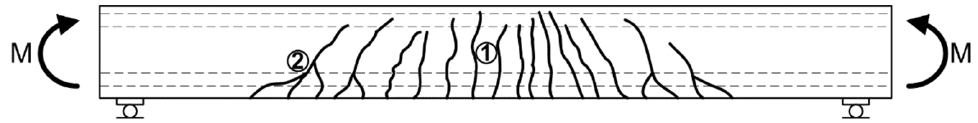
Figure 6. Macrocracks due to bending; 1—single cracks, 2—collective cracks, M —bending mo- ment.